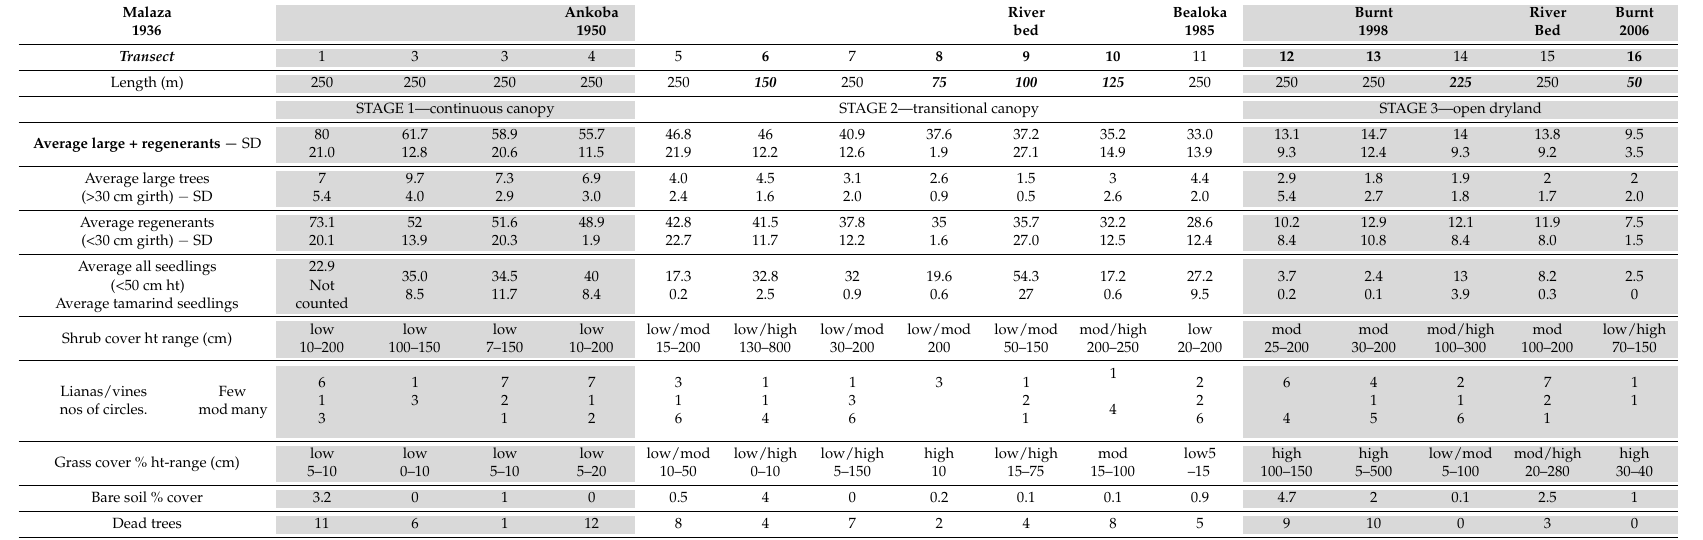
Table 1. Rapid site assessment data for transects, divided into 3 stages. The transects are arranged in descending order of average large plus small trees, defined as ‘regenerants’ by Elliott et al. [18]. Regenerants are saplings and small trees <30 cm girth. Short transect lengths are italicized and highlighted. Averages are based on counts per circle in each transect. Standard deviations (SD) indicate considerable variability between